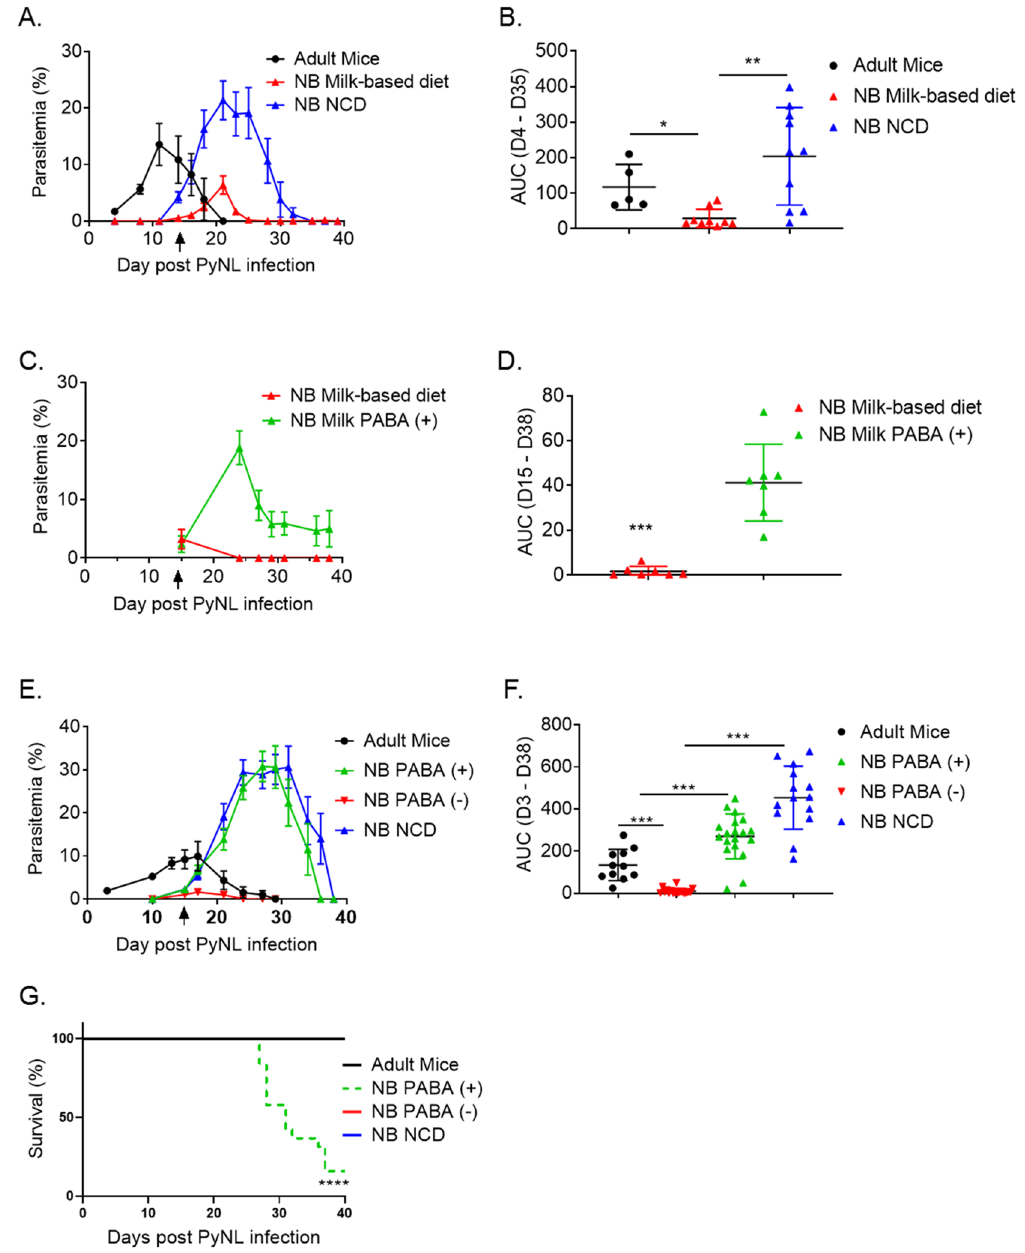
Figure 2. Parasitemia levels decrease when weanlings are fed with a milk-based diet or PABA-deficient diet. ( A ) Two groups of 6- to 7-days old NB and 7- to 8-weeks old adult C57BL/6 mice were infected with 1 × 10 6 PyNL parasites. Five adult mice were fed with NCD throughout the experiment. At the weaning time point (day 21 post birth, black arrow), one group of weanlings were fed with milk-based diet for 2 weeks, and the other group with NCD. The number of mice in the milk-based diet and the NCD groups were 11 and 10, respectively. Parasitemia levels were assessed by blood smears on indicated time points until clearance. ( B ) AUC of parasitemia burden between days 4 to 35 post infection shown in panel A are plotted. ( A , B ) Cumulative data (mean ± SEM) from two experiments are shown. ( C ) Two groups of 6- to 7-days old NB mice, each group containing 7 mice, were infected with 1 × 10 6 PyNL parasites. NB mice were weaned at day 21 post birth (black arrow) and were fed with milk-based diet or milk-based diet containing PABA (PABA (+)) for 23 days. Parasitemia levels were evaluated by blood smears on indicated time points. ( D ) AUC of parasitemia burden between days 15 to 38 post infection shown in panel C are plotted. ( C , D ) Data (mean ± SEM) from one experiment is shown. ( E ) Three groups of 6- to 7-days old NB mice were infected with 1 × 10 6 PyNL parasites. NB mice were weaned at day 21 post birth (black arrow) and were fed with PABA-containing (PABA (+)), PABA-deficient (PABA (-)) or NCD. Parasitemia levels were evaluated by blood smears on indicated time points until clearance. ( F ) AUC of parasitemia burden between days 3 to 38 post infection shown in panel E are plotted. ( E , F ) Cumulative data (mean ± SEM) from two experiments containing 19, 17, 14 and 12 mice in PABA (+), PABA (−), NCD, and adult mice groups, respectively, are shown. Student’s t-test was used to compare the AUC between groups. *p < 0.05, **p < 0.01, and *** p < 0.001. ( G ) The survival of mice in panel E was assessed until 40 days after infection. Results are expressed as survival curves analyzed using the Log-rank (Mantel Cox) test for 12 PABA (+), for 10 PABA (−) and for 10 NCD mice. ****p < 0.0001 indicates comparison of survival between PABA ( +) group and the mice in the other groups (PABA (-), NB NCD and Adult